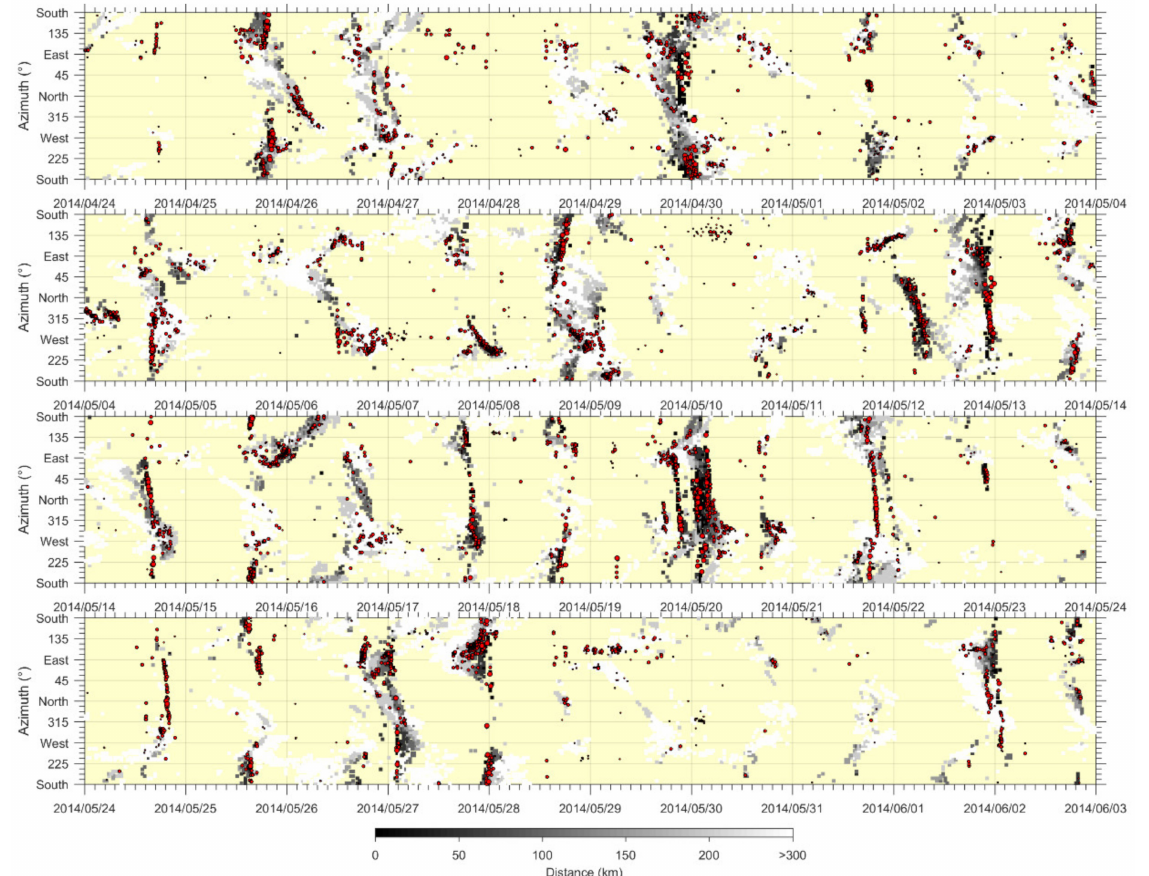
Figure 4. Comparison of the azimuths of the infrasound detections with the ones of the WWLLN detections from 24 April to 3 June 2014. The flashes’ azimuths are calculated according to the IS17 station; they are plotted as squares, color-coded according to their distance to IS17. The infrasound detections are shown as red circles whose size is proportional to their RMS